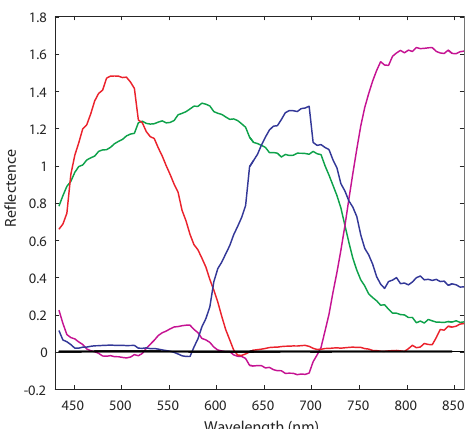
Figure 3. The curves of endmember signature, in which the curve of each color represents an endmember or